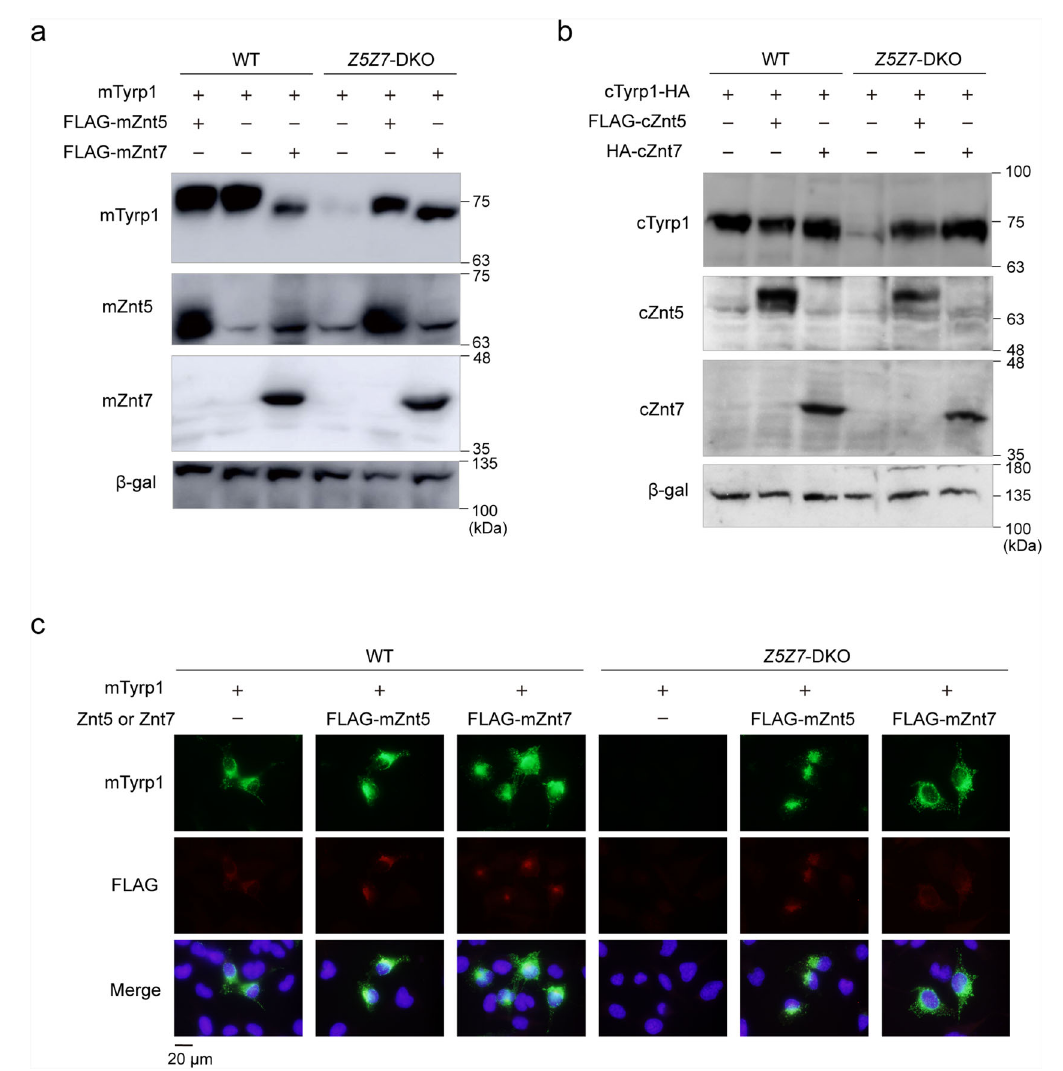
Fig. 5 TYRP1 expression is dependent on functional ZNT5 or ZNT7 transporters. a Immunoblot analysis of TYRP1, TYR, and TYRP2 in wild-type (WT) SK-MEL-2 cells and SK- Z5Z7 -DKO cells transfected with plasmids encoding TYRP1, TYR and TYRP2. Note that TYRP1, but not TYR and TYRP2, was substantially decreased in SK- Z5Z7 -DKO cells. b Con fi rmation of substantial reduction in TYRP1 expression using immuno fl uorescence staining. c Immunoblot and d immuno fl uorescence microscopy showing restoration of TYRP1 expression in SK- Z5Z7 -DKO cells following re-expression of wild type ZNT5 or ZNT7, but not of zinc transport-incompetent mutants of ZNT5 and ZNT7 (ZNT5 H451A and ZNT7 H70A ). e Ba fi lomycin A1 (BafA1) treatment stabilizes the expression of TYRP1, transiently transfected in SK- Z5Z7 -DKO cells. SK- Z5Z7 -DKO cells were treated with the indicated concentrations of MG132 and BafA1 for 6 h. In c , d , TYR, TYRP1, and TYRP2 plasmids and ZNT plasmids were transfected at a ratio of 1:10. In a , c , and e , β -galactosidase ( β -gal) was used as a transfection control. Each experiment was performed at least three times, and representative results from independent experiments are shown.